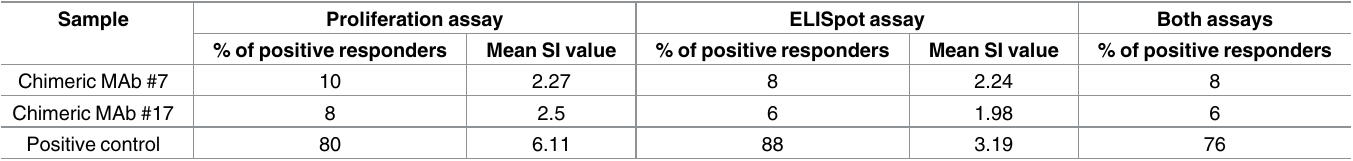
Table 5. Summaryof T cell activation